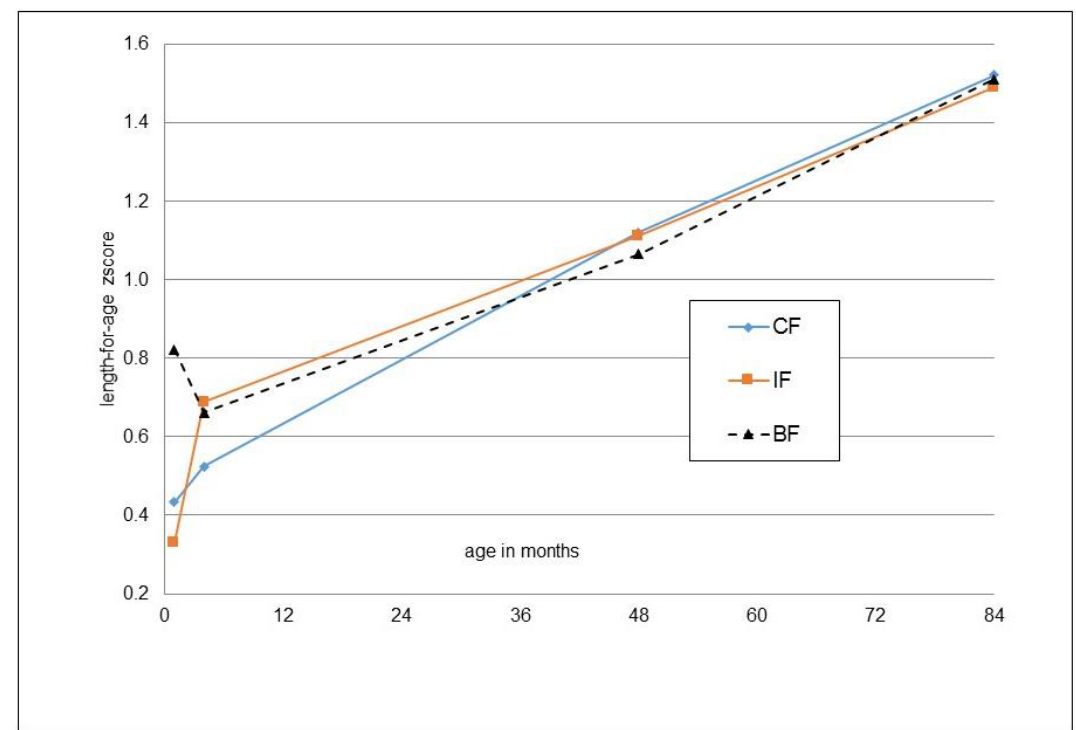
Figure 3. Mean z-scores for length-for-age at one month (IF: n = 50, CF: n = 54, BF: n = 57), four months ( n = 50, n = 54, n = 57), four years ( n = 48, n = 52, n = 57) and seven years ( n = 50, n = 54, n = 57) for those children participating in the 7-year follow-up; no significant difference between IF and CF, t -test.